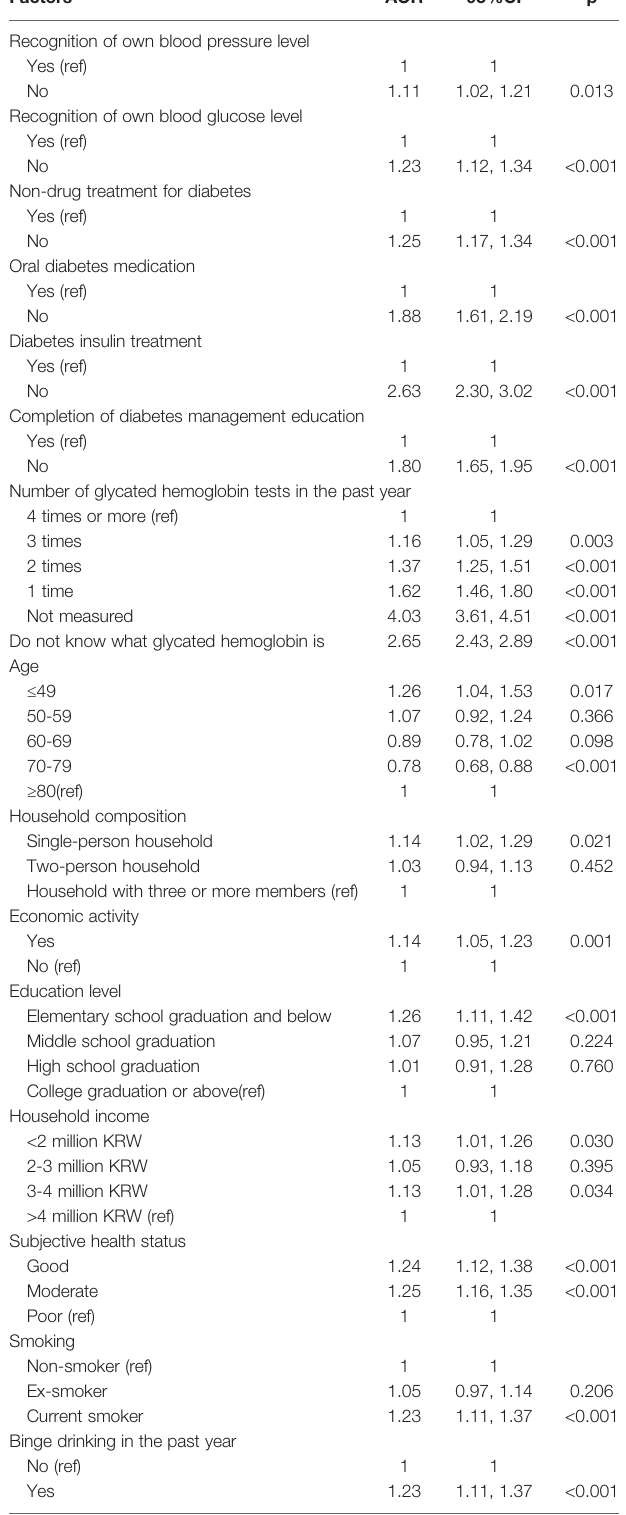
TABLE 3 | Predictor for the non-utilization of eye disease (fundus examination) in South Korean diabetic patients: AOR and 95% CI.